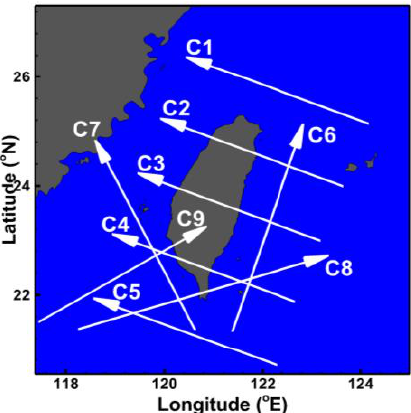
Figure 1. Nine categories classified by the Central Weather Bureau of Taiwan based on typhoon tracks.